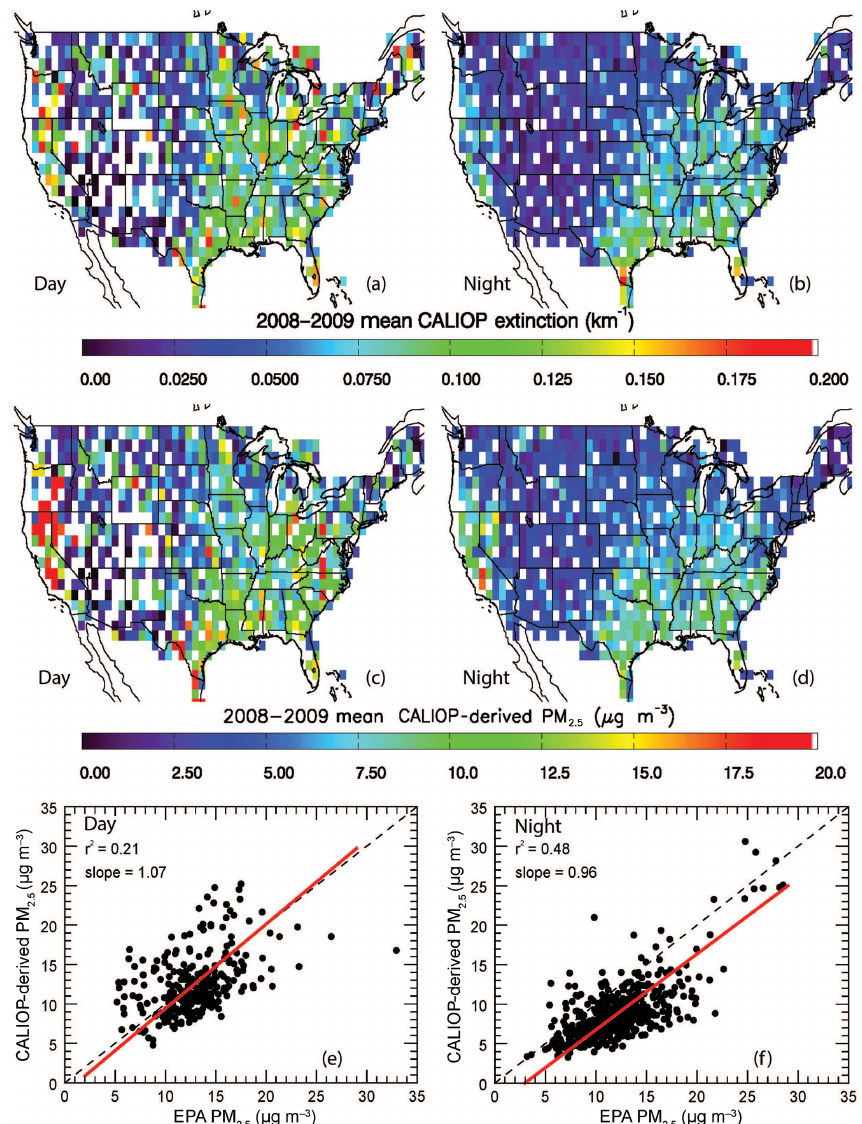
Figure 3. For 2008–2009 over the CONUS, 1 ◦ × 1 ◦ average CALIOP extinction, relative to the number of cloud-free 5km CALIOP profiles in each 1 ◦ × 1 ◦ bin, for the 100–1000ma.g.l. atmospheric layer, for (a) daytime and (b) nighttime measurements. Also shown are the corresponding CALIOP-derived PM 2 . 5 concentrations, using Eq. (3) for (c) daytime and (d) nighttime conditions. Values greater than 0.2km − 1 and 20µgm − 3 for (a, b) and (c, d) , respectively, are colored red. Scatter plots of mean PM 2 . 5 concentration from ground-based U.S. EPA stations and those derived from collocated near-surface CALIOP observations are shown in the bottom row, using (e) daytime and (f) nighttime CALIOP data. The red lines represent the Deming regression